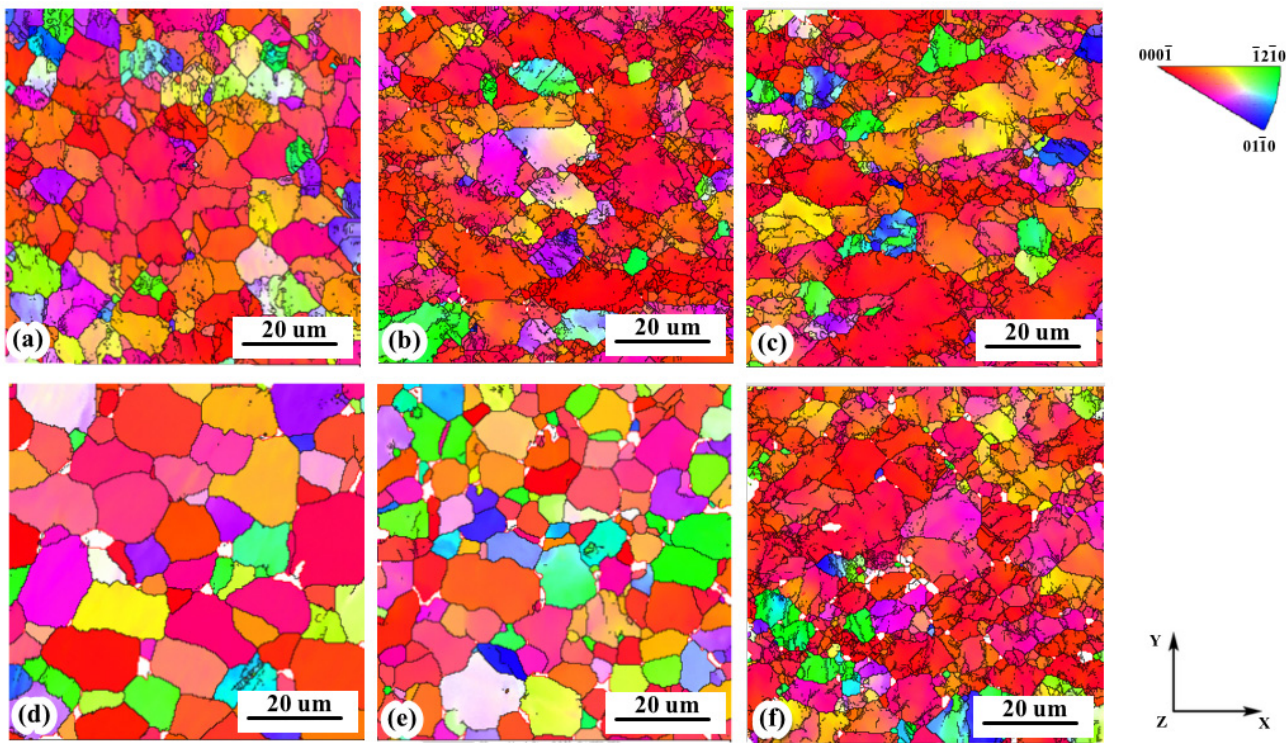
Figure 7. EBSD inverse pole figures at: ( a ) 930 °C, 10 − 2 /s; ( b ) 800 °C, 10 − 2 /s; ( c ) 600 °C, 10 − 2 /s; ( d ) 930 °C, 10 − 4 /s; ( e ) 800 °C, 10 − 4 /s; ( f ) 600 °C, 10 − 4 /s.